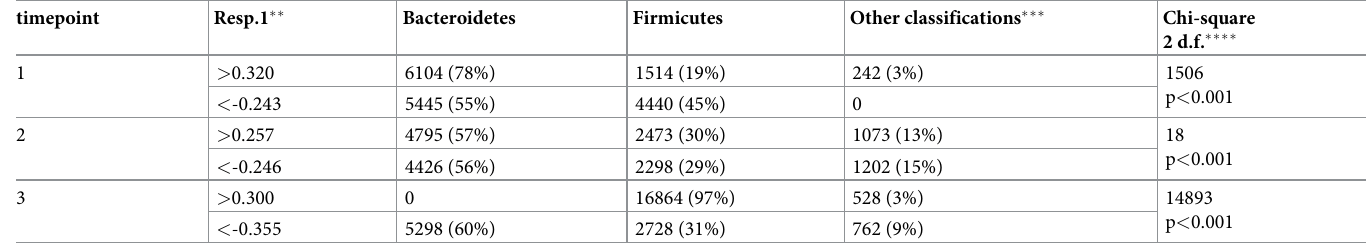
Table 3. Taxa significantly associated with age �